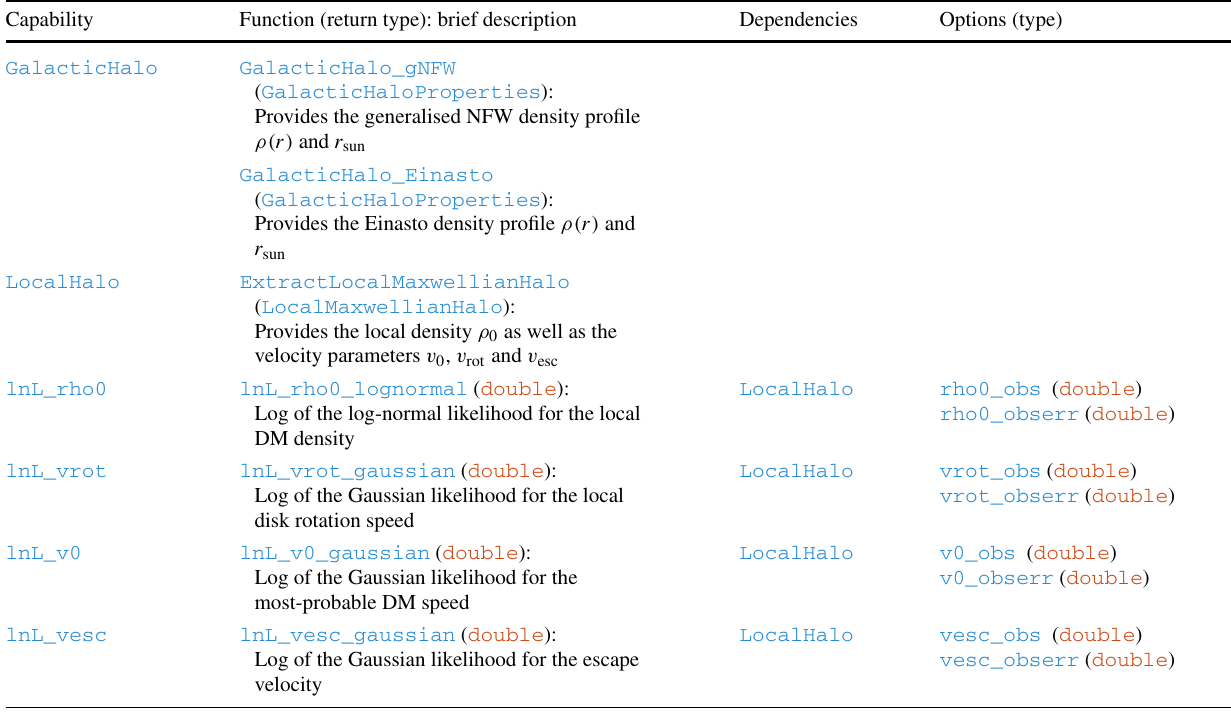
Table 15 Capabilities connected to the Milky Way halo parameters